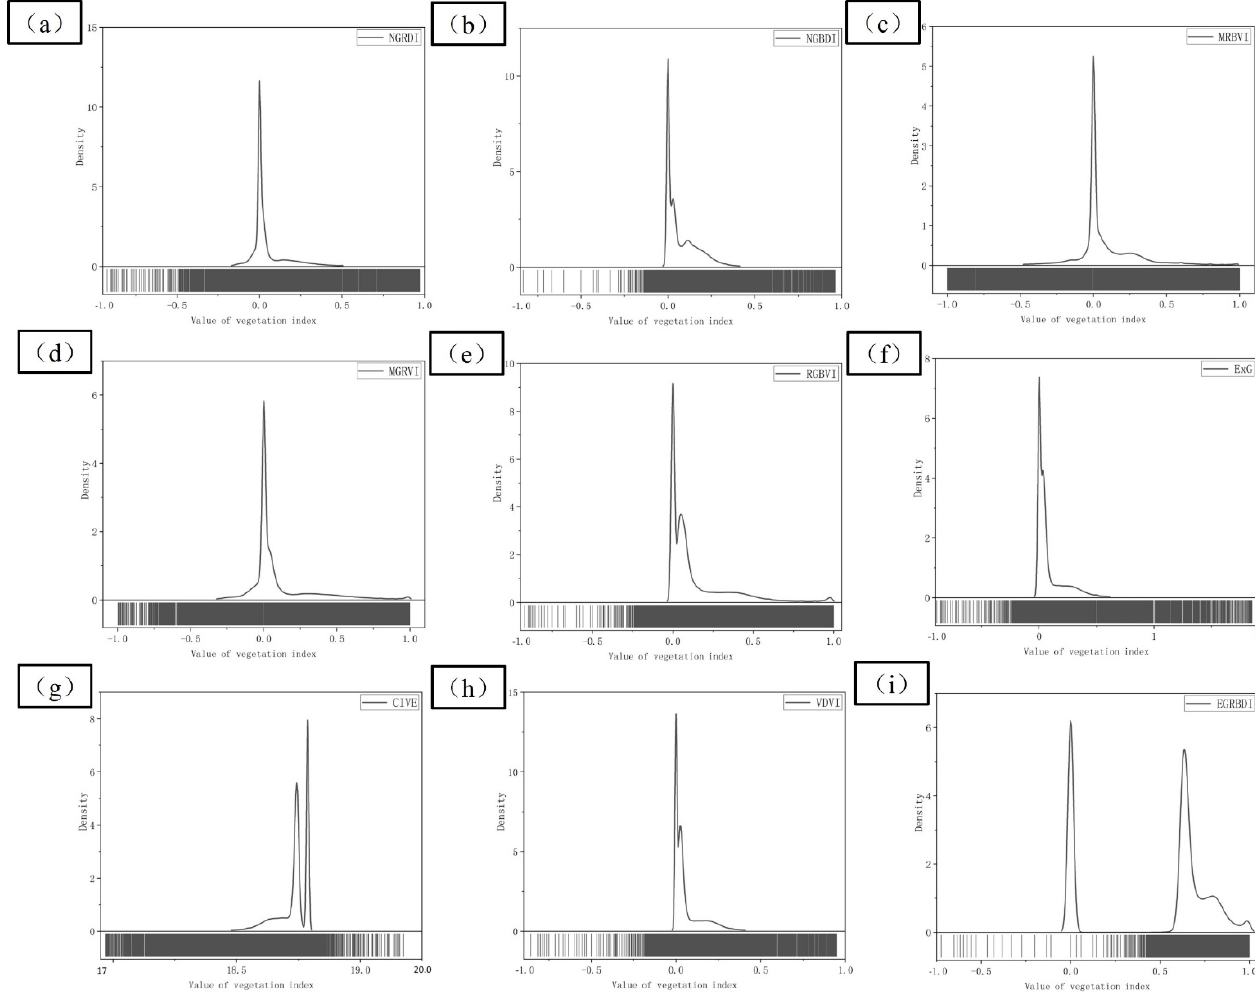
Figure 13. ( a – i ) Calculation results of statistical histogram each visible VI.